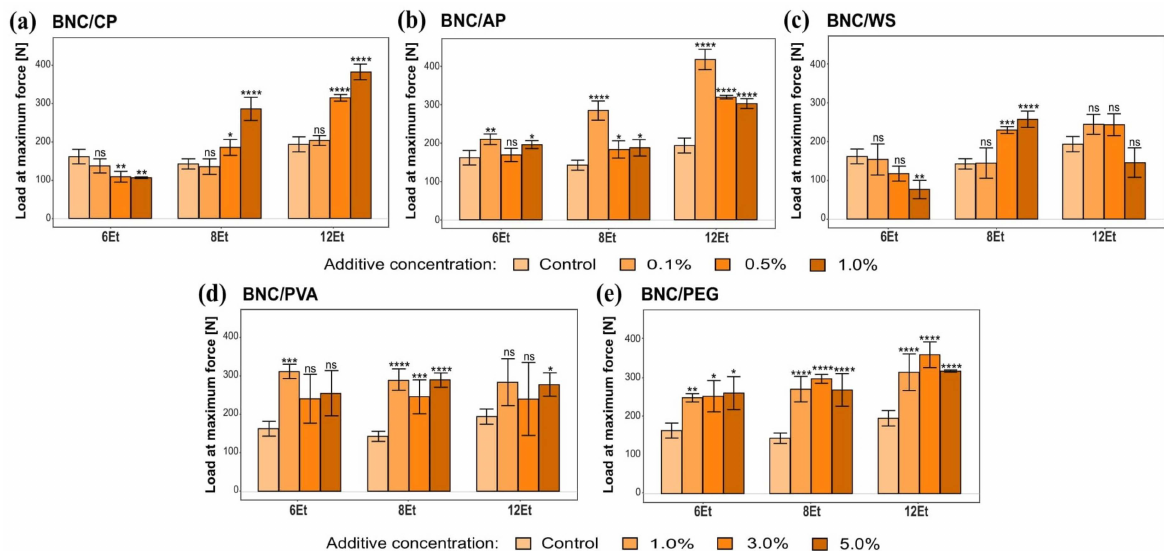
Figure 14. The maximum force required to break bacterial cellulose composites produced by K. hansenii H3 (6Et), K. rhaeticus K4 (8Et), and the strain isolated from balsamic vinegar (12Et). ( a ) BNC/CP, ( b ) BNC/AP, ( c ) BNC/WS, ( d ) BNC/PVA, and ( e ) BNC/PEG. Statistically significant differences were calculated using a one-way ANOVA with Tukey’s multiple comparison post-hoc test and are shown as * = p ≤ 0.05, ** = p ≤ 0.01, *** = p ≤ 0.001, and **** = p ≤ 0.0001, compared to control (native)